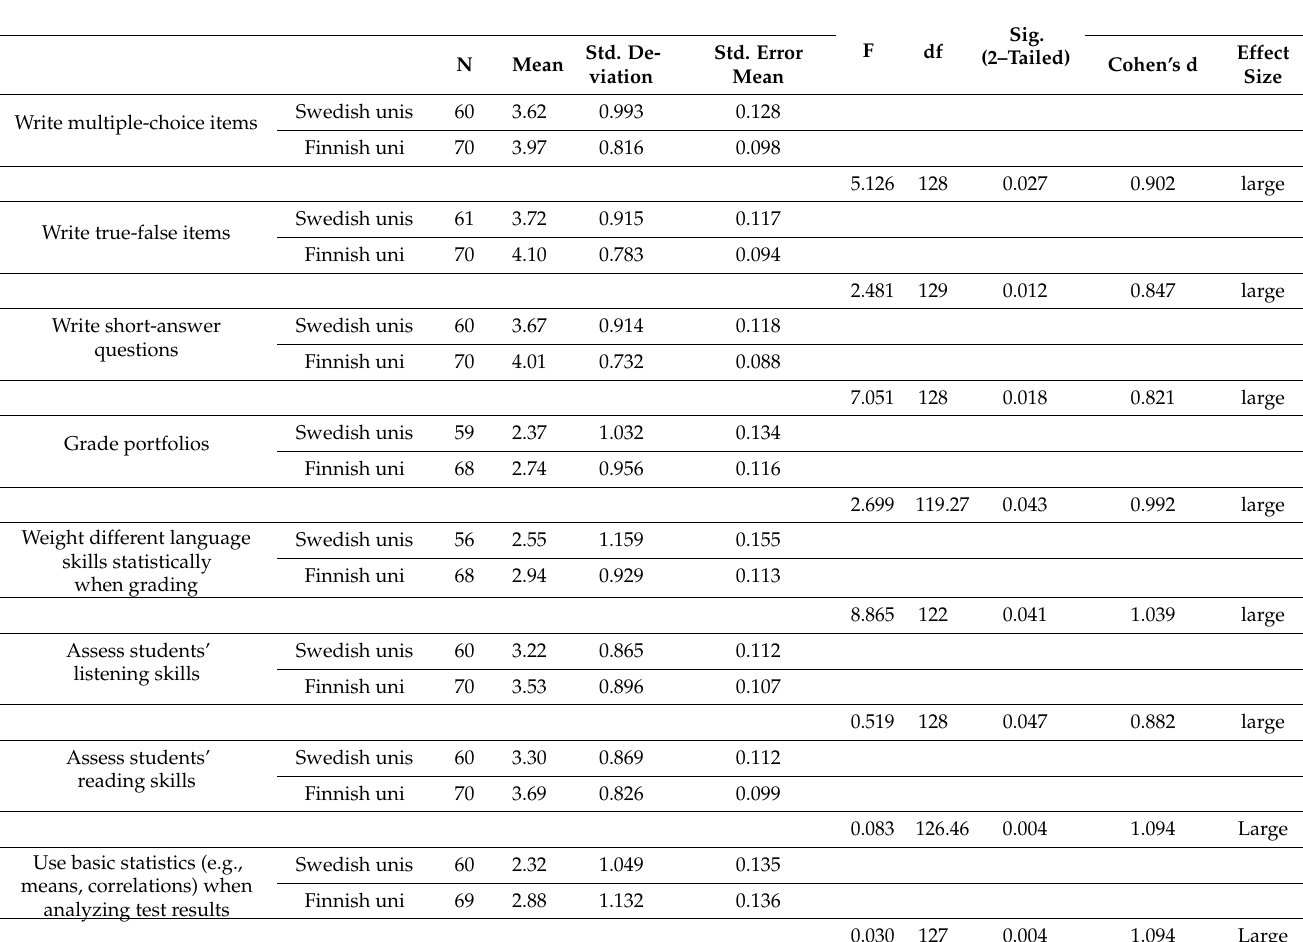
Table 8. Comparison of pre-service teachers’ perceived competence in summative assessment prac- tices in Sweden and Finland.